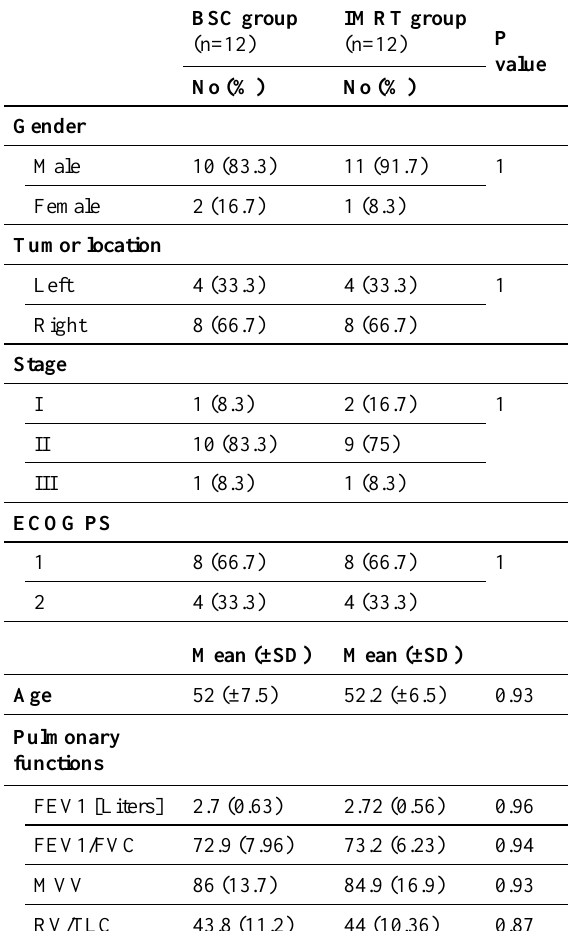
Table 1. Baseline patients’ characteristics